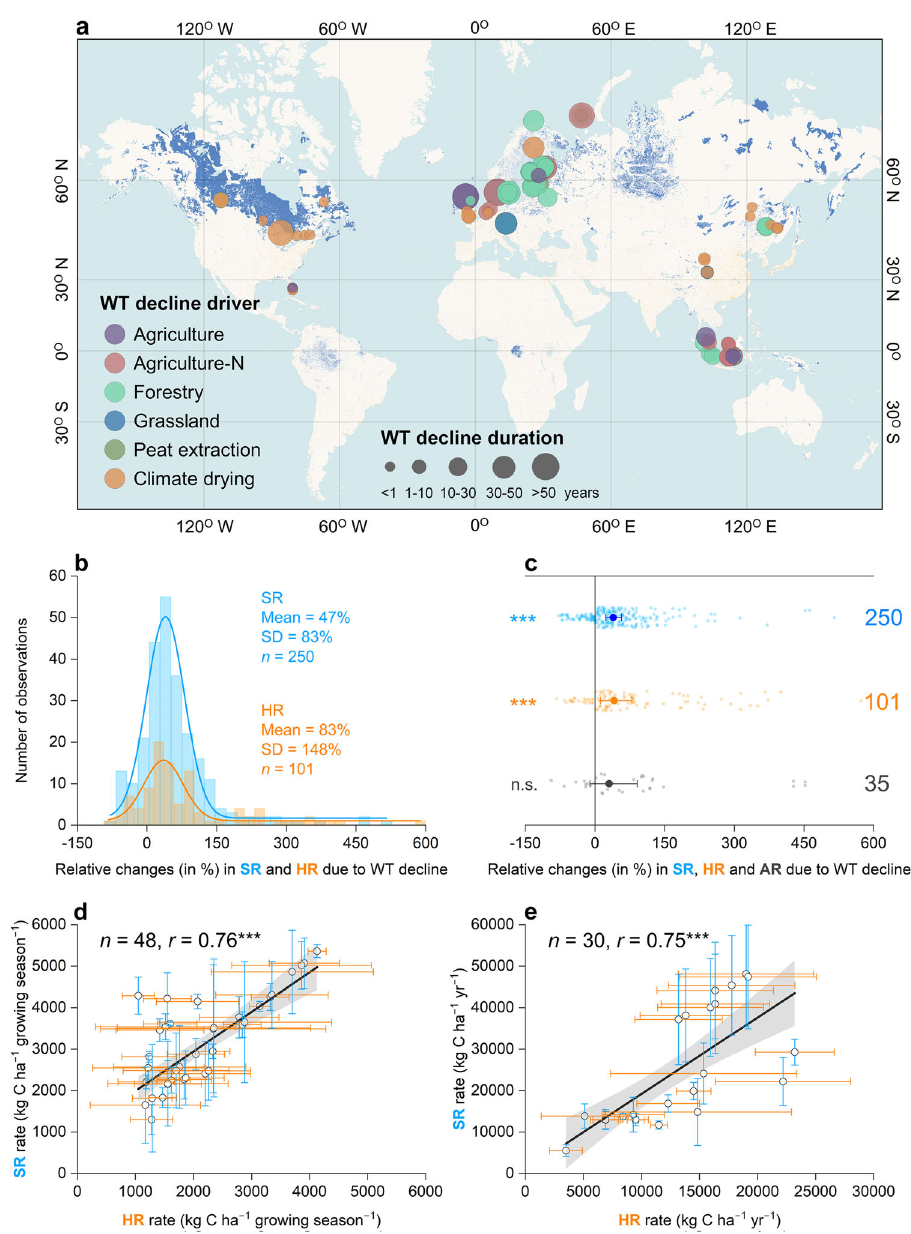
Fig. 1 Relative changes in soil respiration (SR) and its components, heterotrophic respiration (HR) and autotrophic respiration (AR), due to water table (WT) decline in global pristine peatlands. a Distribution of the in situ observations. b Frequency distributions of the relative changes in SR and HR due to WT decline (AR was not shown due to the scarcity of data points ( n = 35)). c Relative changes in SR, HR, and AR due to WT decline. d Pearson correlation of the growing season HR and SR rates in pristine and drained boreal peatlands. e Pearson correlation of the annual HR and SR rates in pristine and drained tropical peatlands. No data were observed in pristine and drained temperate peatlands. Each data point for WT decline impacts on in situ SR and its components were classi fi ed on the basis of the driver of WT decline and duration of WT decline in a . The gray – blue regions in a indicate the global distributions of peatlands derived from PEATMAT 5 . The larger solid circles and horizontal bars in c denote the weighted means of relative changes and their 95% con fi dence intervals. The smaller circles and numbers in c indicate individual relative changes due to WT decline and the number of data points, respectively. The open circles and bars in d , e show the means and standard deviations for individual data points. The asterisks *, **, *** indicate signi fi cance at the levels of p < 0.05, 0.01 and 0.001, respectively, and n.s. indicates no signi fi cance (for details, see Meta-analysis in